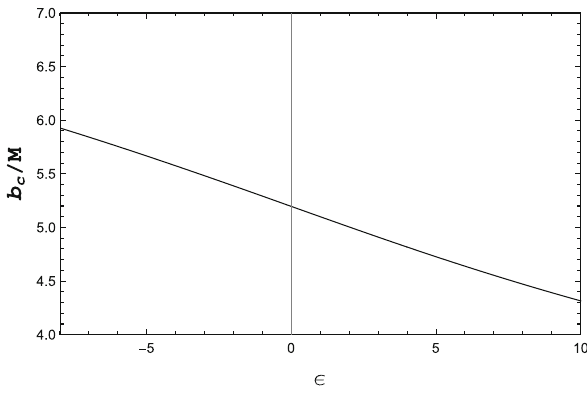
Fig. 4 Critical impact parameter b c , plotted as a function of ε for JPBHs